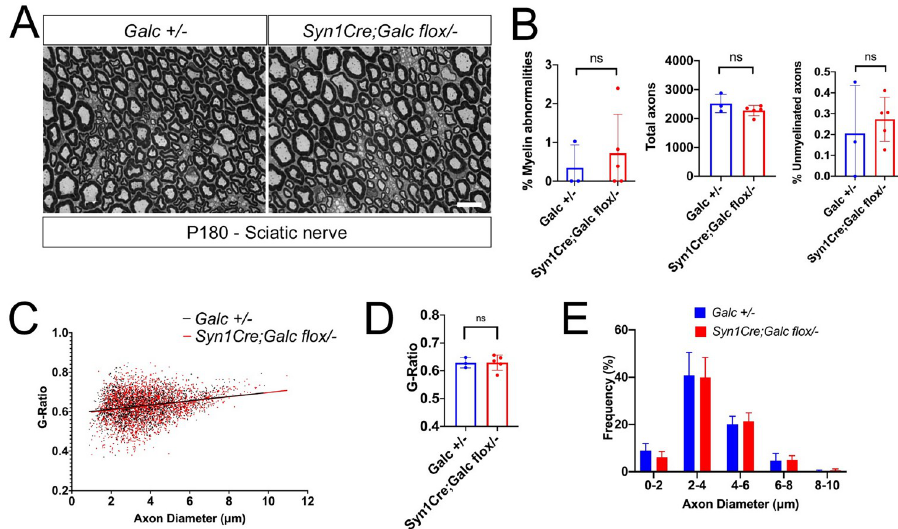
Fig 8. Sciatic nerve did not show any morphological change. ( A ) Representative semi-thin sections of P180 sciatic nerves from Syn1Cre; Galc flox/− ( N = 5) and control ( N = 3). Scale bar = 10 μ m. ( B ) Myelin abnormalities were not significantly increased in the mutant. ( C–E ) Peripheral myelin thickness and distribution of axonal diameter were not changed in the Syn1Cre; Galc flox/− , compared to control ( Galc flox/−) . N = 5. All data are presented as mean values + /− SEM. Two-way ANOVA with Tukey multiple comparison tests were used. � P < 0.05, �� P < 0.01 and ��� P < 0.001. ns, not significant. The underlying data for B – E can be found in S1 Data. GALC,